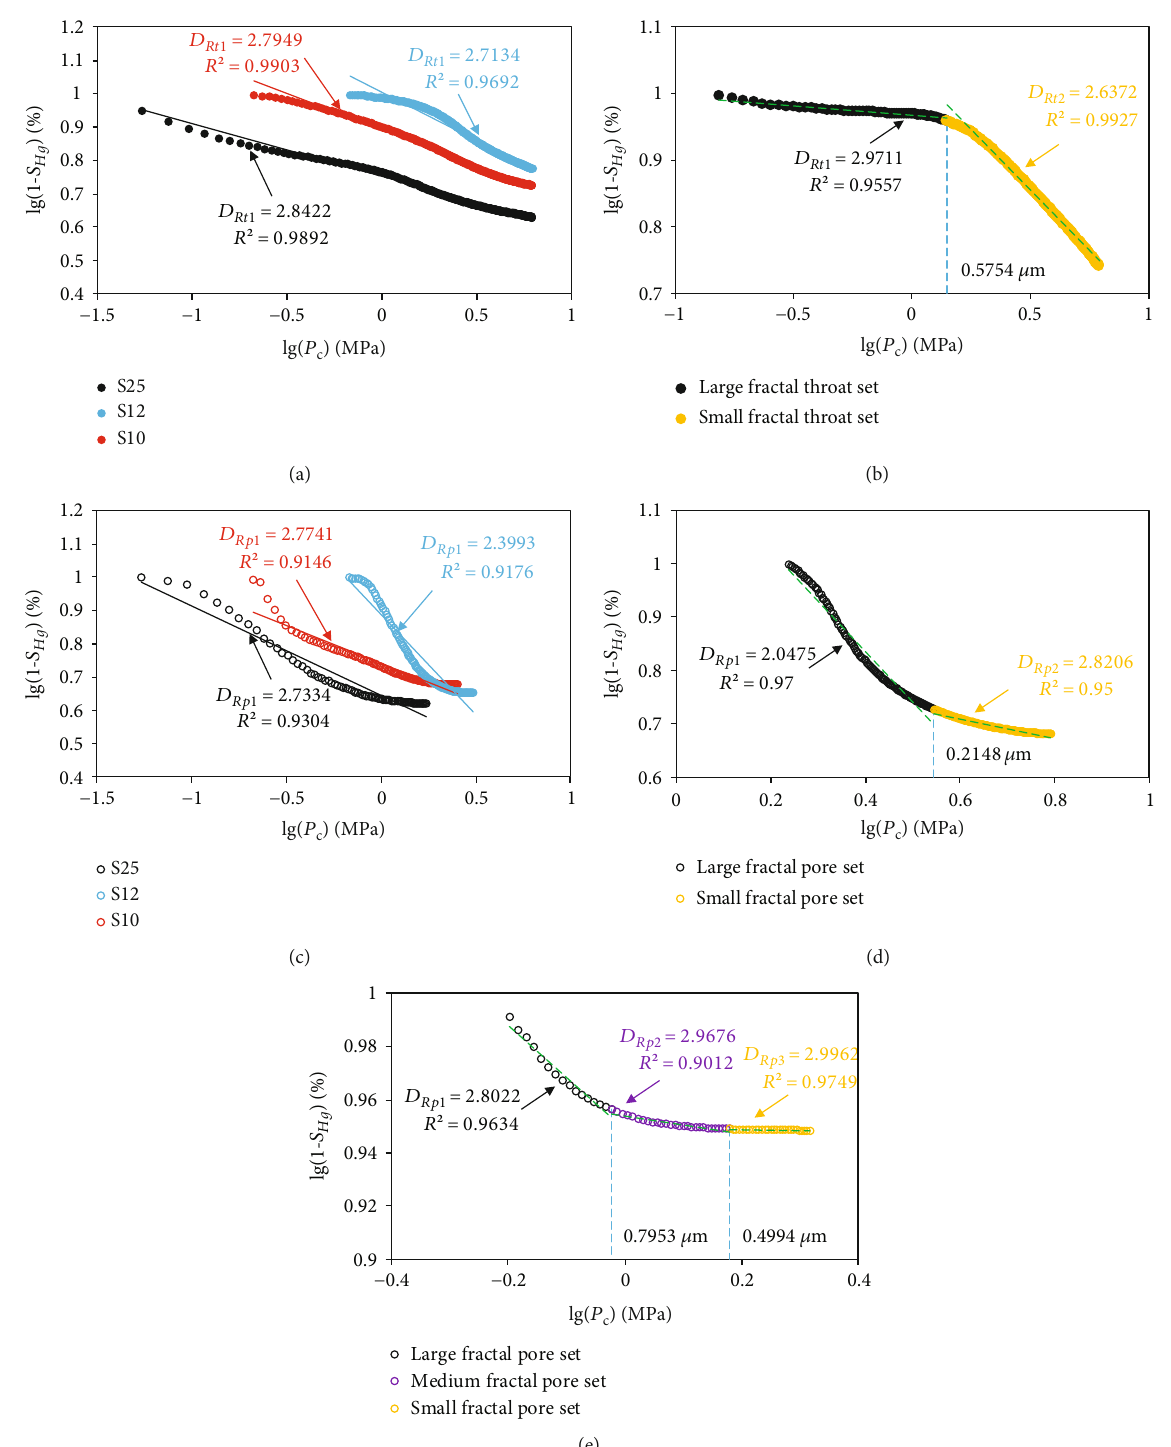
Figure 5: Double logarithmic plots of wetting phase saturation versus capillary pressure from RCMI experiments: (a) type I of the throat set from three typical specimens; (b) type II of the throat set from S46; (c) type I of the pore set from three typical specimens; types (d) II and (e) III of the pore set from S26 and S78, respectively. D : fractal dimension values from throat branches of RCMI tests or large fractal throat set; Rt 1 : small fractal throat set; D : fractal dimension values from pore branches of RCMI tests or large fractal pore set; D D Rt 2 Rp 1